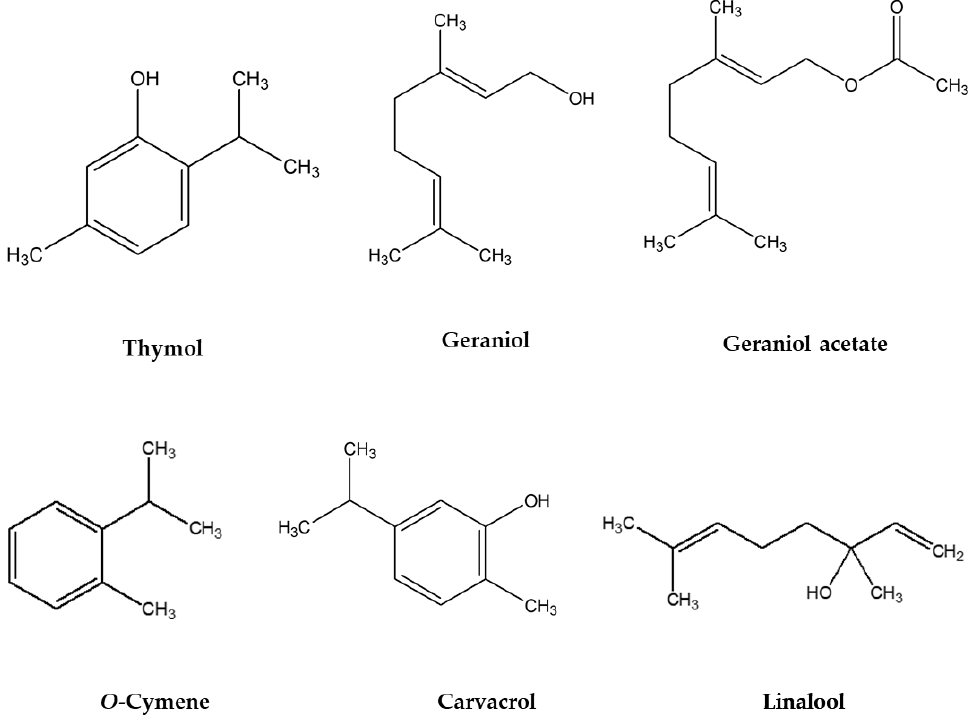
Figure 1. Chemical structures of different chemotypes identified in the essential oils of T. quinque- costatus populations. Table 2. Characteristics of essential oil components selected for PCA analysis.